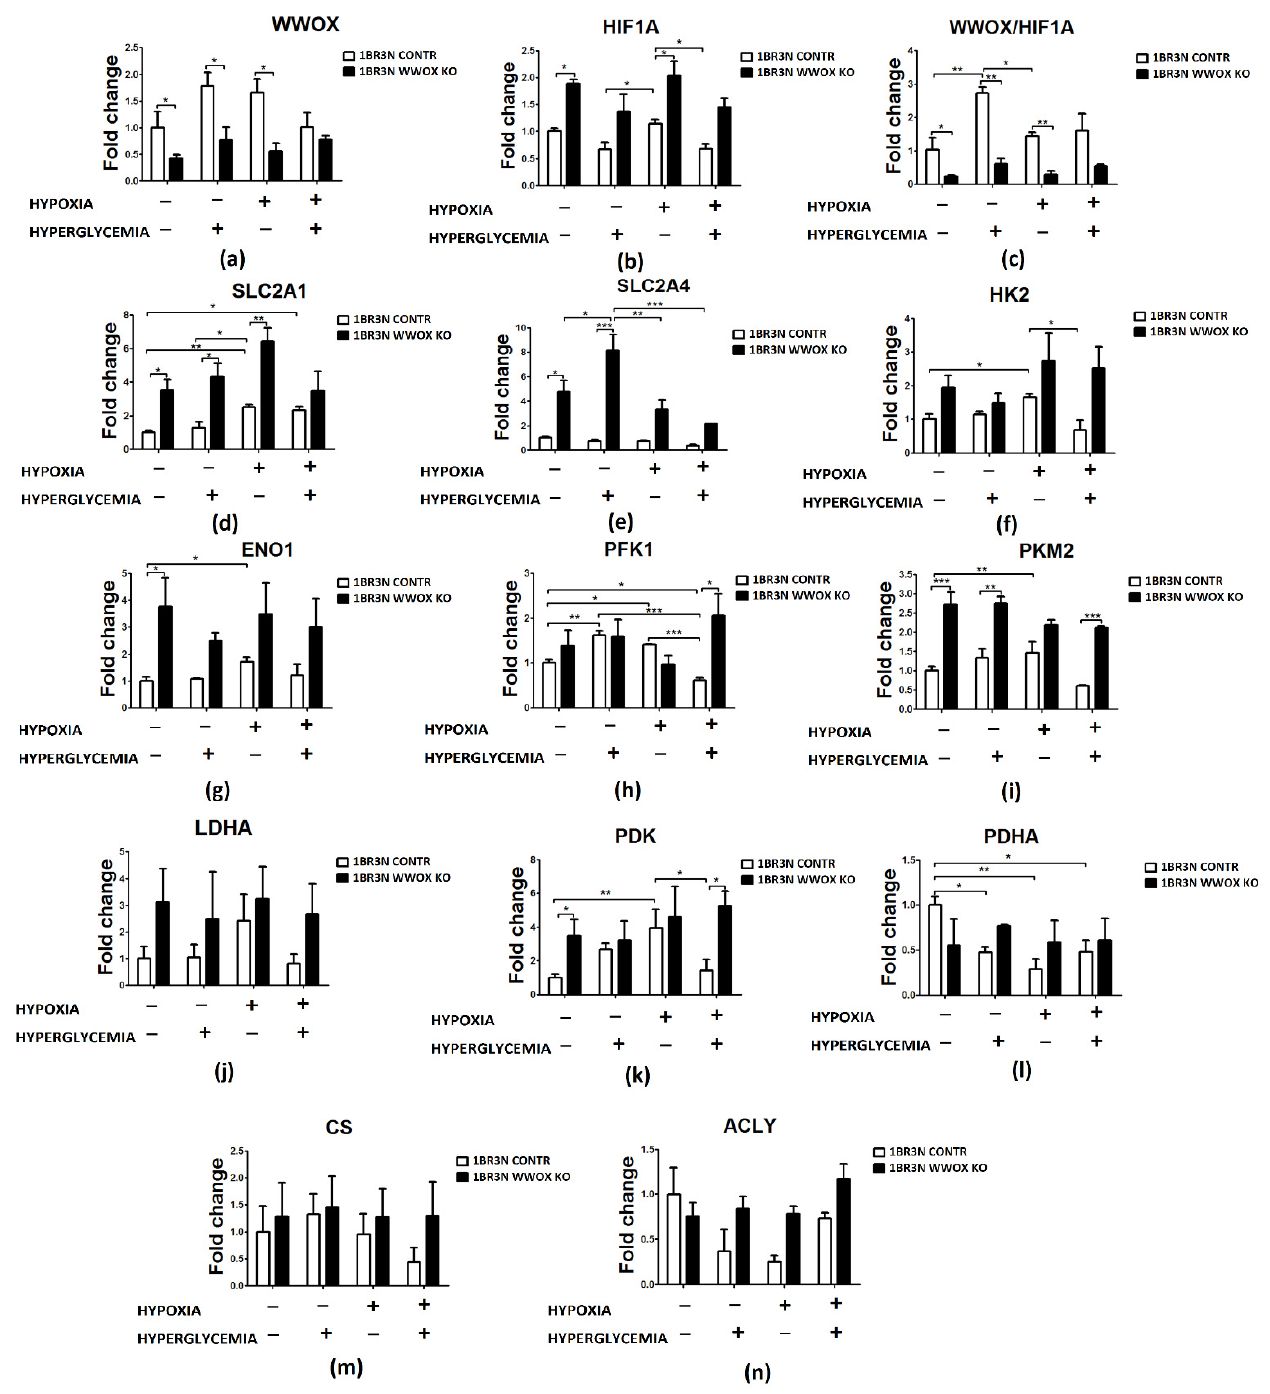
Figure 4. Relative expression fold change of glycolysis-associated genes detected by RT-qPCR in WWOX -silencing 1BR.3.N cells after 48h incubation in four tested condition. Bar graphs showing the relative mRNA expression (the ratio of the target gene relative to the reference genes RPS17, RPLP0, H3F3A ) of WWOX ( a ), HIF1A ( b ), the WWOX/HIF1A ratio ( c ) and all WWOX/HIF-related genes including those involved in glucose transport ( SLC2A1 ( d ), SLC2A4 ( e )), glycolytic pathway ( HK2 ( f ), ENO1 ( g ), PFK ( h ), PKM2 ( i ), LDHA ( j )), PDK ( k ), PDHA ( l ), CS ( m ) and ACLY ( n ). Results of ANOVA with a post-hoc Tukey-Test are shown as mean ± SEM. *, p < 0.05; **, p < 0.01; ***, p < 0.001. In normoxia hyperglycemia conditions, lactate dehydrogenase activity ( p < 0.01) and lactate level ( p < 0.001) was still upregulated in 1BR.3.N WWOX KO cells in